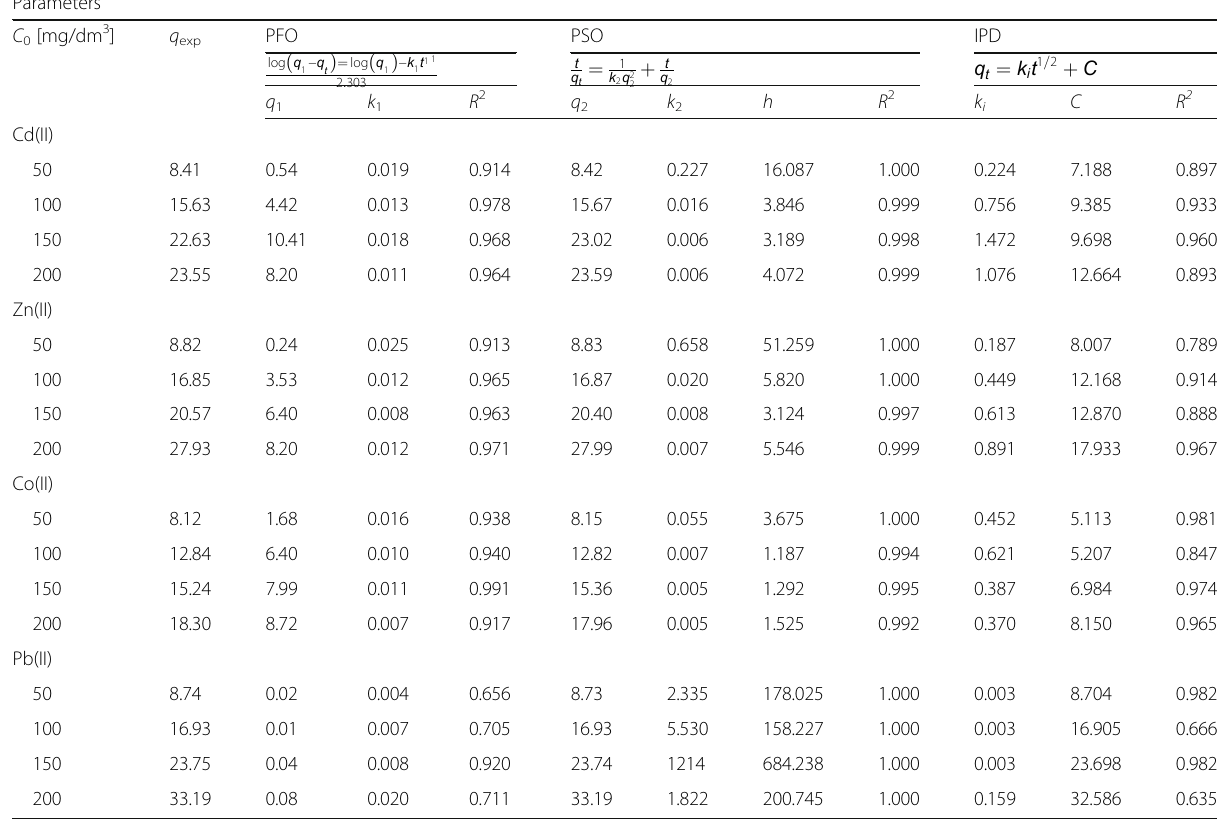
Table 2 Parameters for various adsorption kinetic models for Cd(II), Co(II), Zn(II) and Pb(II) sorption on MBC2 Parameters